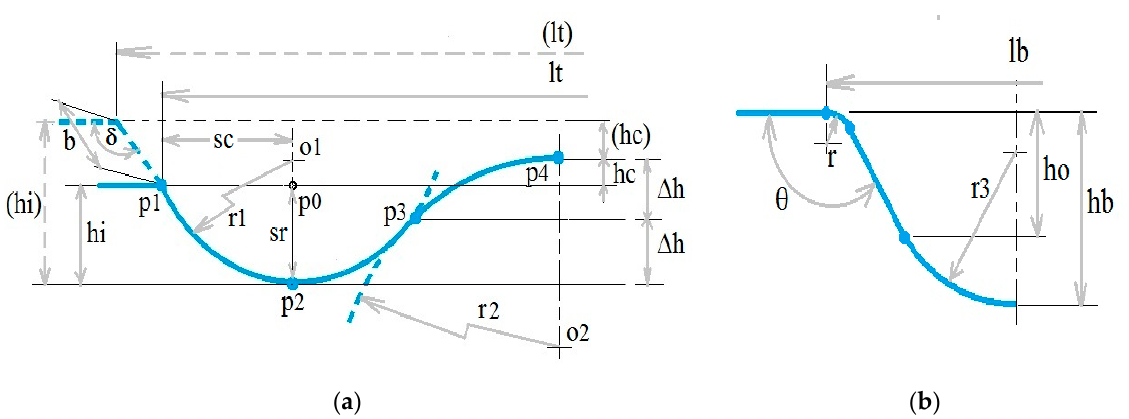
Figure 3. Sketch of the idealized profiles and their geometrical parameters: ( a ) t-profile; ( b ) b-profile.